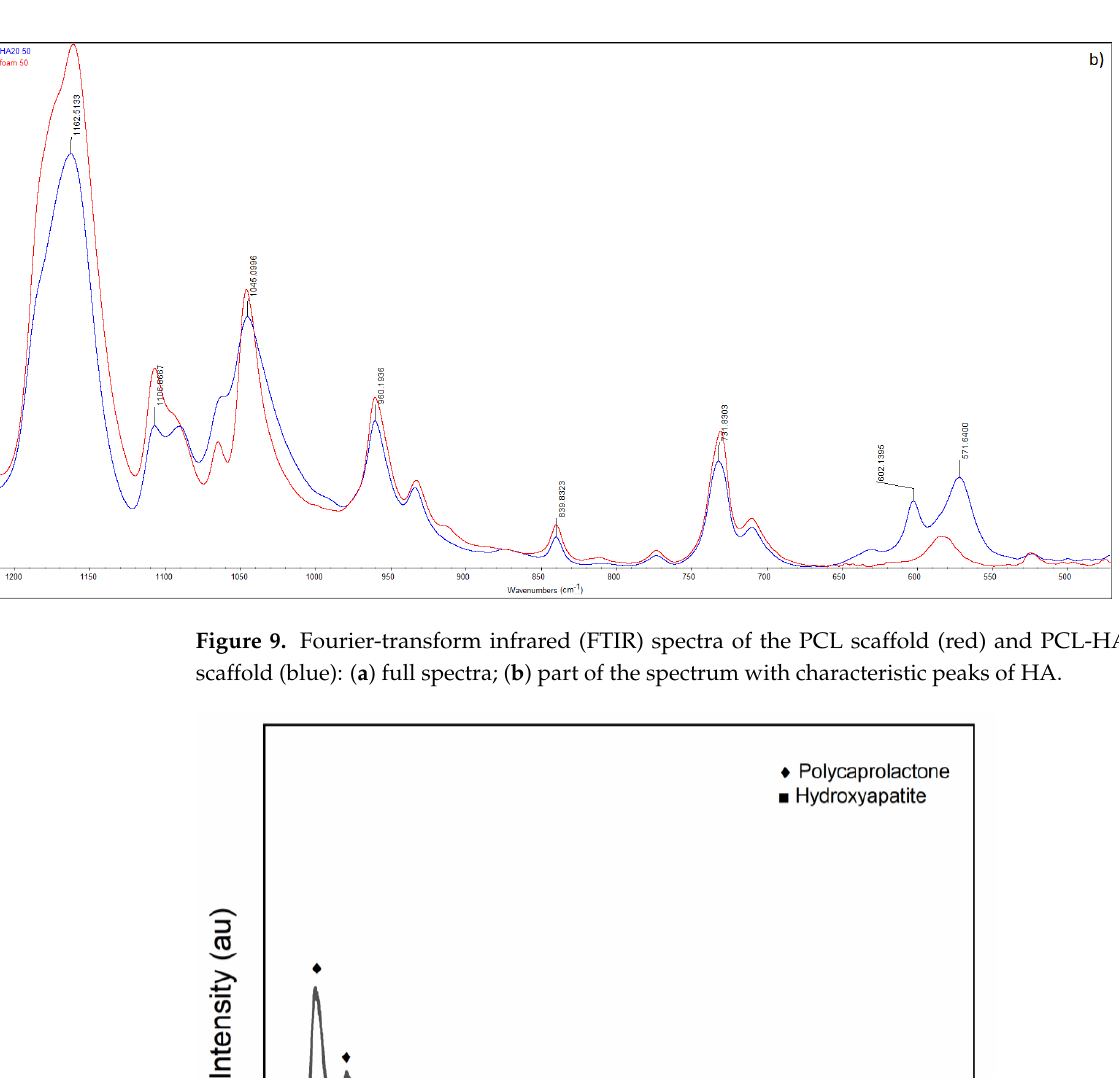
Processes 2022 , 10 , 482 15 of 22